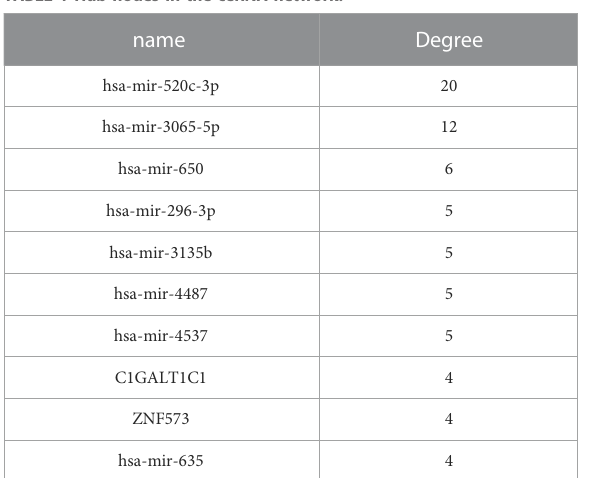
TABLE 1 Hub nodes in the ceRNA